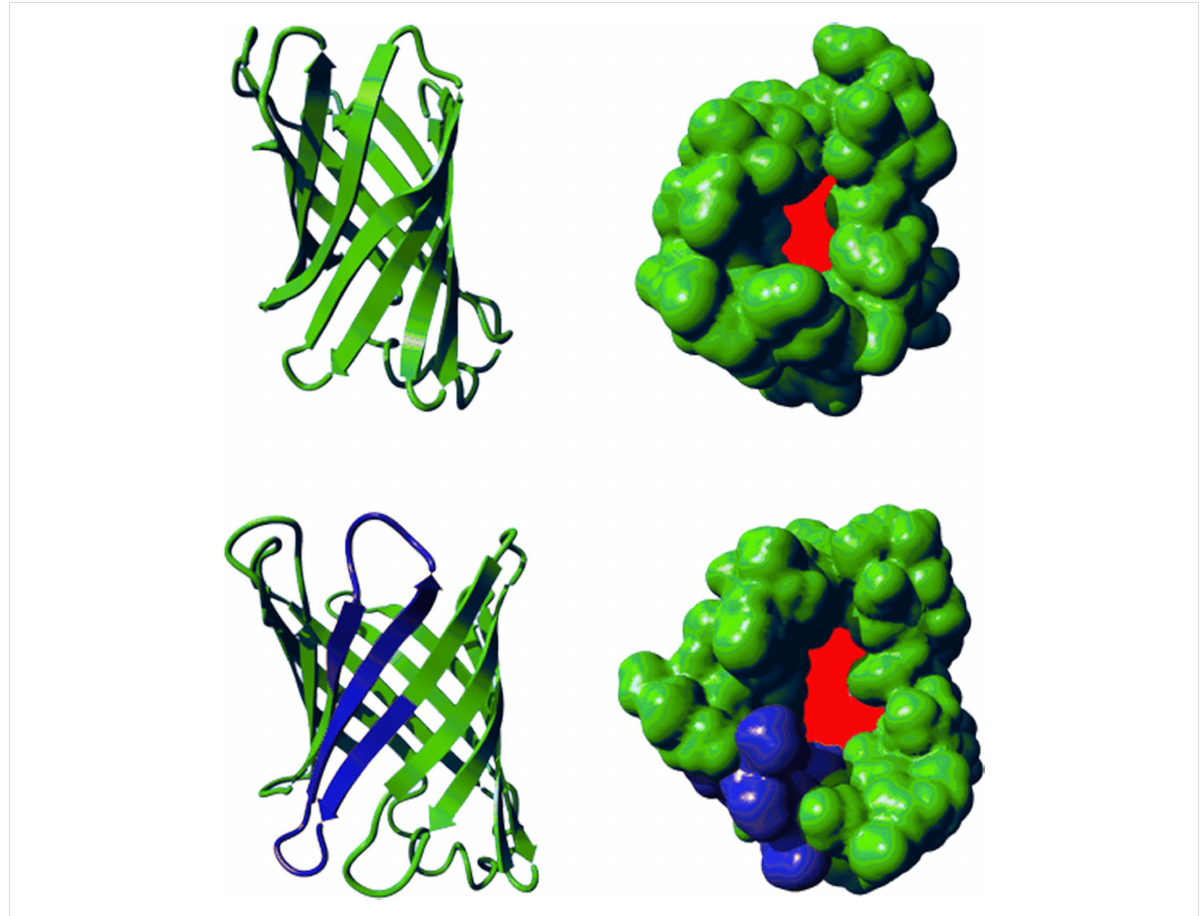
Figure 2: Top: NB4 (PDB 3WJB); bottom: NB4exp. Highlighted in blue are the additional two β -sheets. Highlighted in red is the diameter of the